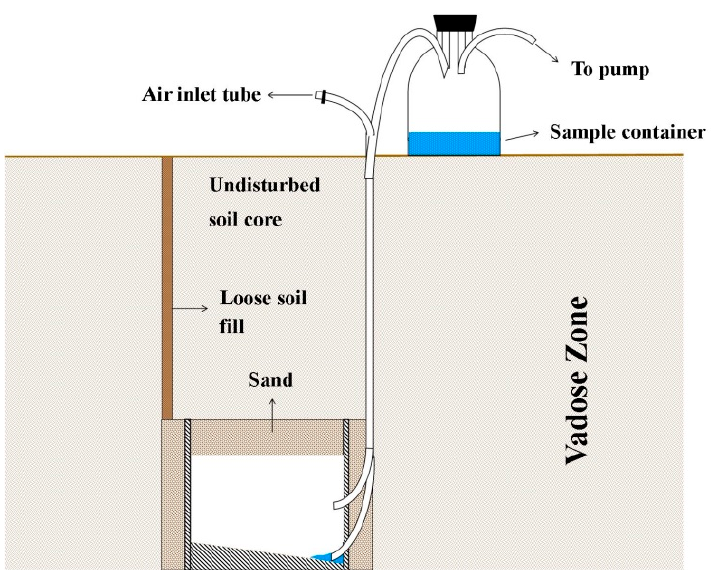
Figure 3. Components of zero-tension lysimeter (adapted from Thompson and Scharf [38]). 3.2. Runoff